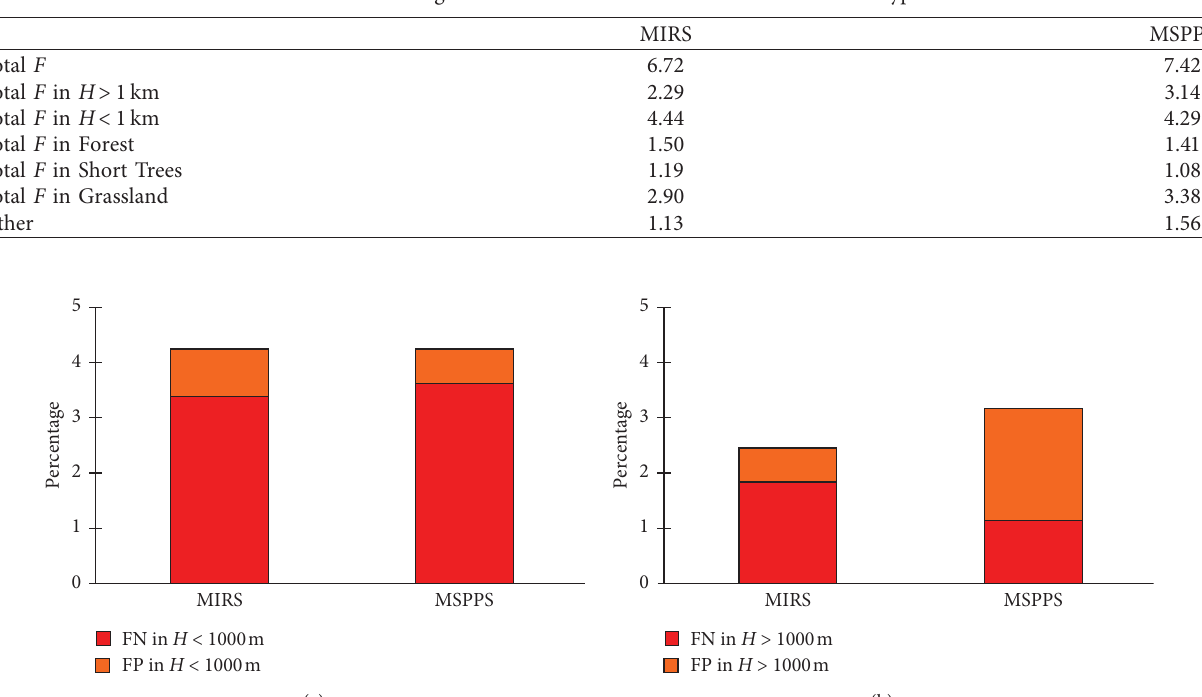
Figure 9: Percentage area of false indicators for MIRS and MSPPS. Red color shows the false negative (underestimation) percentage and orange color shows the false positive (overestimation) percentage. Table 1: Percentage of total false classification of each land cover type.